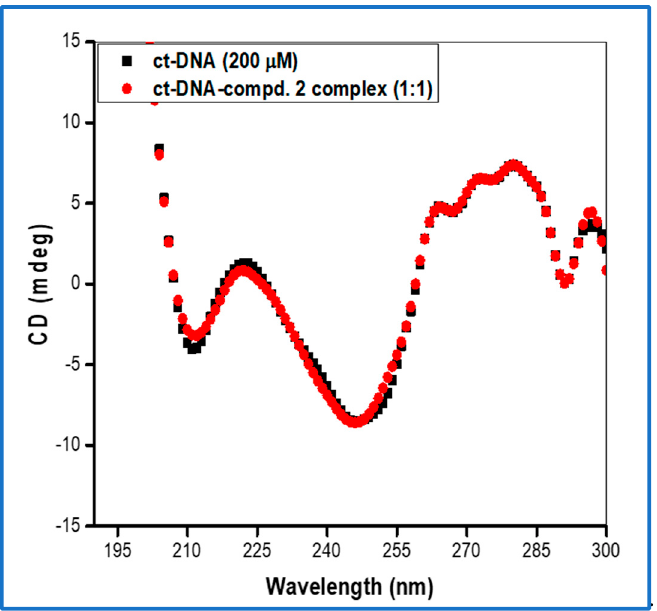
Figure 16. The CD spectra of ct-DNA (200 µ M) alone and ct-DNA complexed with compound 2 in the molar ratio 1:1.